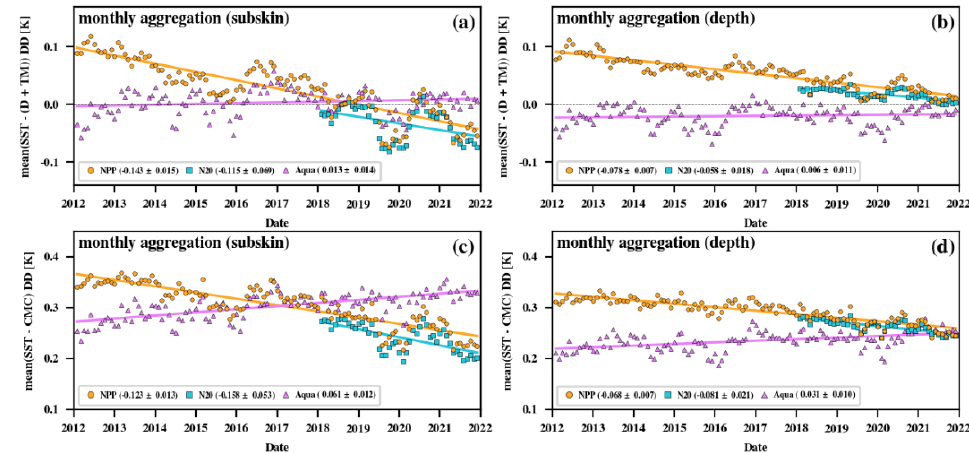
Figure 14. Time series of monthly aggregated ‘day minus night’ DDs calculated from ( a , b ) ACSPO − (D+TM); ( c , d ) ACSPO − L4 Δ SSTs for ( a , c ) ‘subskin’; ( b , d ) ‘depth’ SSTs. Slopes (K/decade; obtained using a linear least squares fit) are provided, along with the associated uncer- tainties obtained using a 95% confidence interval. Lines show the corresponding linear